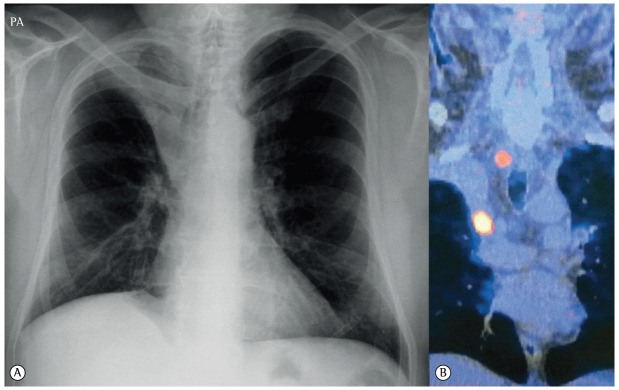
 Em A, radiografia do tórax na incidência posteroanterior demonstrando
imagem triangular radiopaca no lobo superior direito que determina retração
cranial, fissural e do hilo correspondente, sugerindo atelectasia. Em B, imagem
de tomografia por emissão de prótons e TC com fusão de imagens no plano coronal
demonstrando duas imagens ovaladas com hipercaptação do radiofármaco, sendo uma
paramediastinal em lobo superior direito, que determinava oclusão do brônquio
para o lobo superior direito e, consequentemente, atelectasia. A segunda imagem
de lesão situava-se na cadeia paratraqueal direita sugerindo linfonodomegalia
inicialmente mas confirmada pelo exame histopatológico como schwannoma.